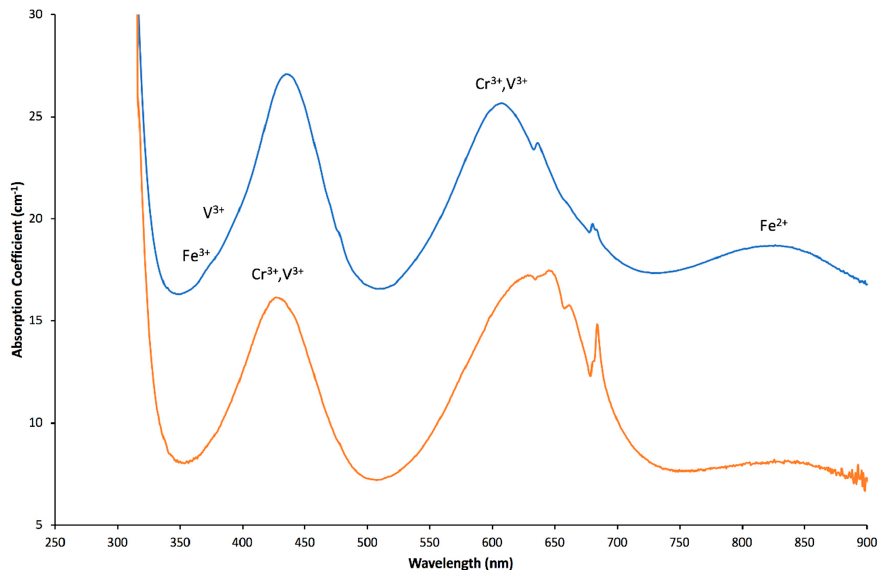
Figure 14. UV ‐ Vis polarized spectra of an emerald from Afghanistan. The light blue and orange lines are for the o ‐ ray and e ‐ ray spectra, respectively. The upper spectrum has been vertically offset for clarity.